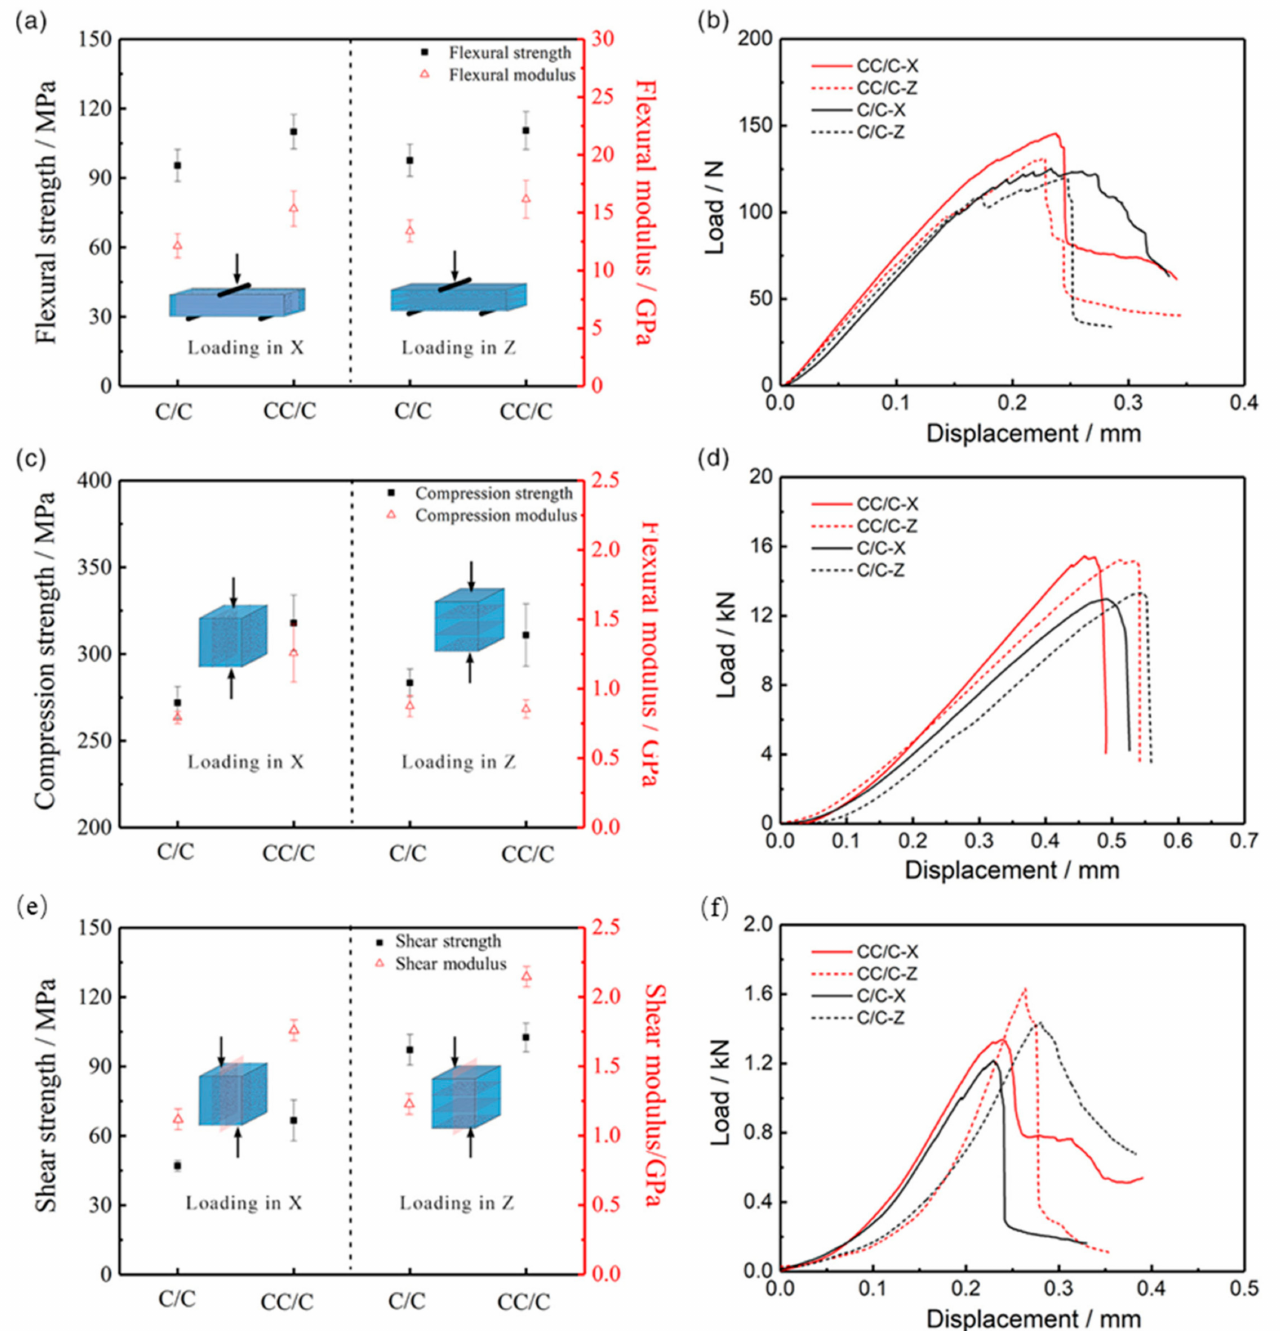
Figure 4. Mechanical properties of CC/C and traditional C/C composites: ( a , b ) Three-point bending test; ( c , d ) Compression test; ( e , f ) Shear